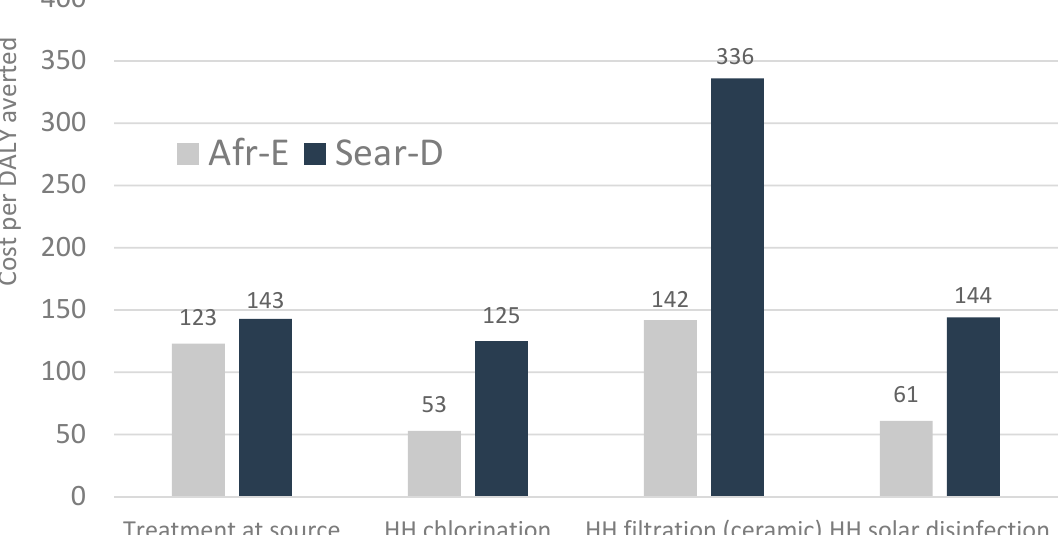
Figure 6. Cost per disability-adjusted life-year (DALY) averted from treatment at source and four household (HH) water supply and water quality interventions in two WHO sub-regions. Africa Epidemiological Stratum D and South and SE Asia Epidemiological Stratum D (US$, 2005). Source: [89].